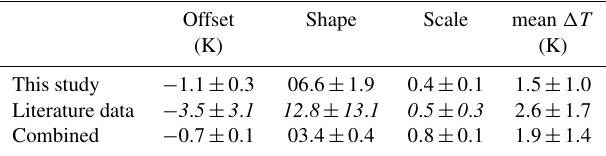
Table 2. Fitting parameters of the gamma distribution (Eq. 4) fit- ted to empirical histograms of temperature drops (cid:49)T during the eclipses and mean (cid:49)T . All values are best estimates ± standard er- ror (SE) of the estimate. Values in italics indicate that the parameter estimates were not significantly different from zero ( p > 0 .